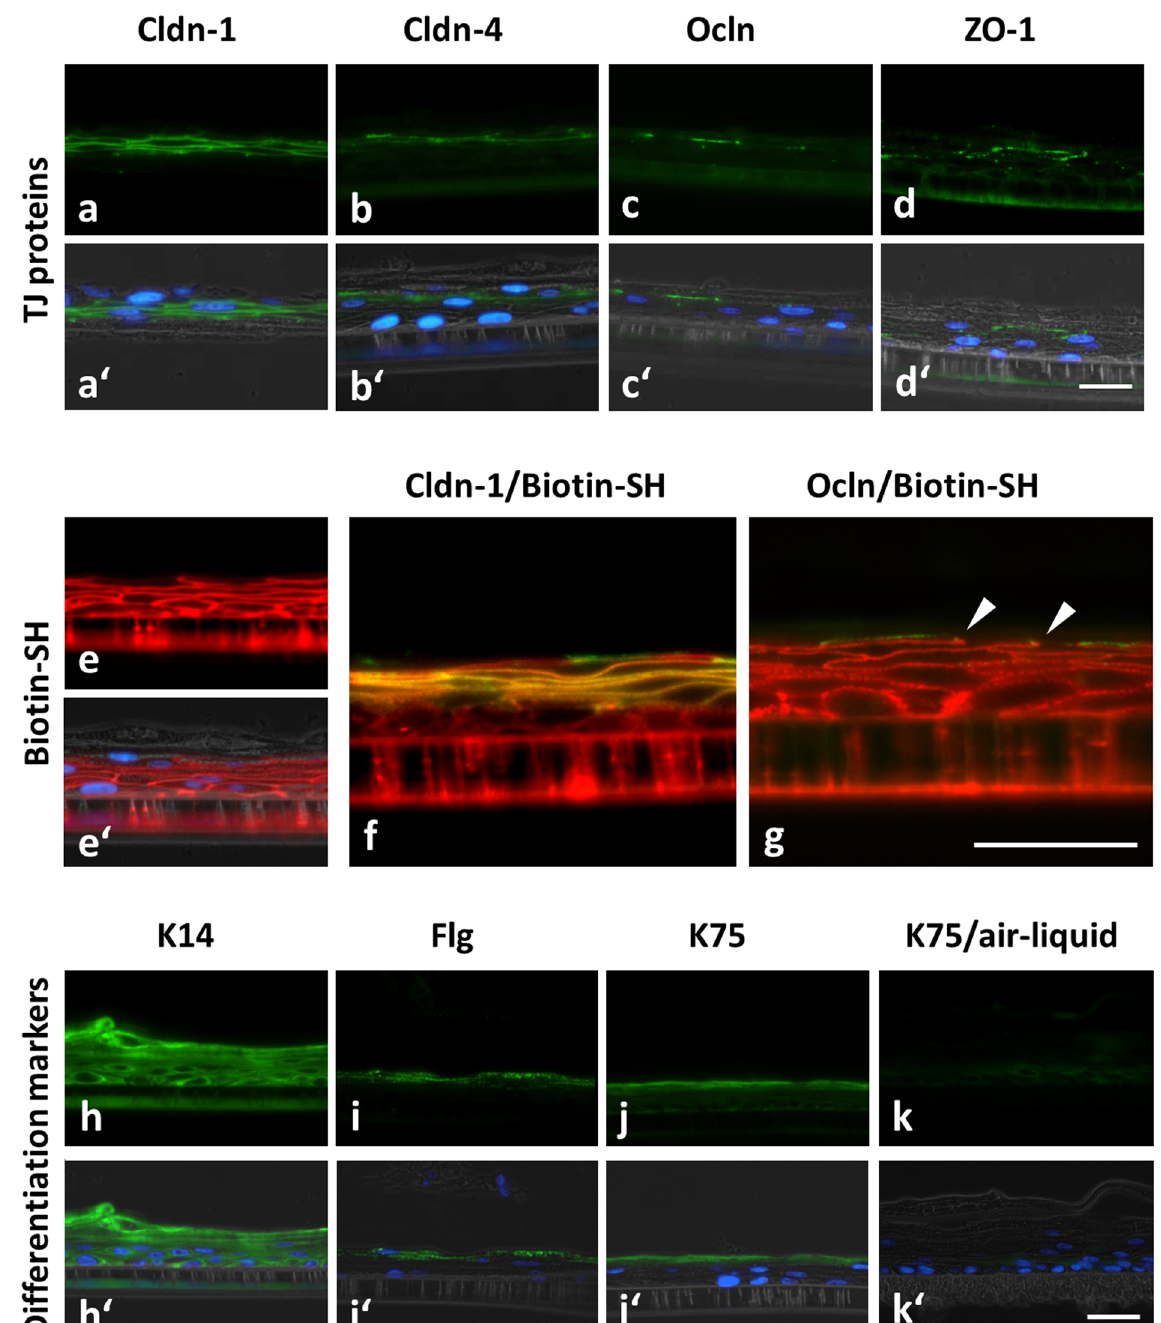
Figure 3. Localization of TJ proteins and TJ barrier as well as differentiation markers in cultured anagen HF keratinocytes. Immunohistochemical stainings of TJ proteins Cldn-1 ( a ,a ′ , f ), Cldn-4 ( b ,b ′ ), Ocln ( c ,c ′ , g ), ZO-1 ( d ,d ′ ) (green) and Biotin-SH ( e ,e ′ , f , g ) (red) and differentiation marker proteins Keratin 14 (K14) ( h ,h ′ ), Filaggrin (Flg) ( i ,i ′ ), and Keratin 75 (K75) ( j ,j ′ ) (green) in ORS keratinocytes isolated from human HFs and cultured submerged on Transwell filters for 8 days. ( k ,k ′ ) K75 in ORS keratinocytes cultured under air-liquid- interface conditions at day 8. (a ′ ,b ′ ,c ′ ,d ′ ,e ′ ,h ′ ,i ′ ,j ′ ,k ′ ) Overlay images with DAPI (nuclei; blue) and phase contrast pictures (grey). ( f , g ) Overlay images of Biotin-SH (red) and Cldn-1 ( f ) and Ocln ( g arrows denote Biotin-SH stops at Ocln) (green) respectively. Scale bars: 20 µ m. Note the HF-like localization of TJ proteins and differentiation markers in the submerged cultures and the absence of HF-specific K75 in air-liquid interface-